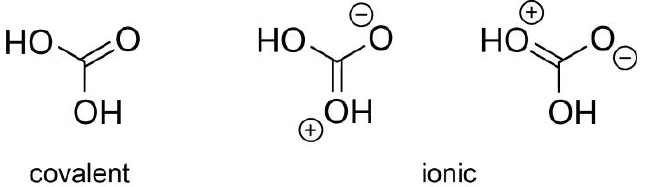
Figure 2. The crystal structure of carbonic acid. Shown is a perspective view [25] into the experi- mentally determined crystal structure ( left ) and the atomic numbering ( right ) of a dimer bonded through hydrogen-bridging bonds (dashed yellow lines); atoms generated by inversion have been indicated by asterisks, e.g., D1*.